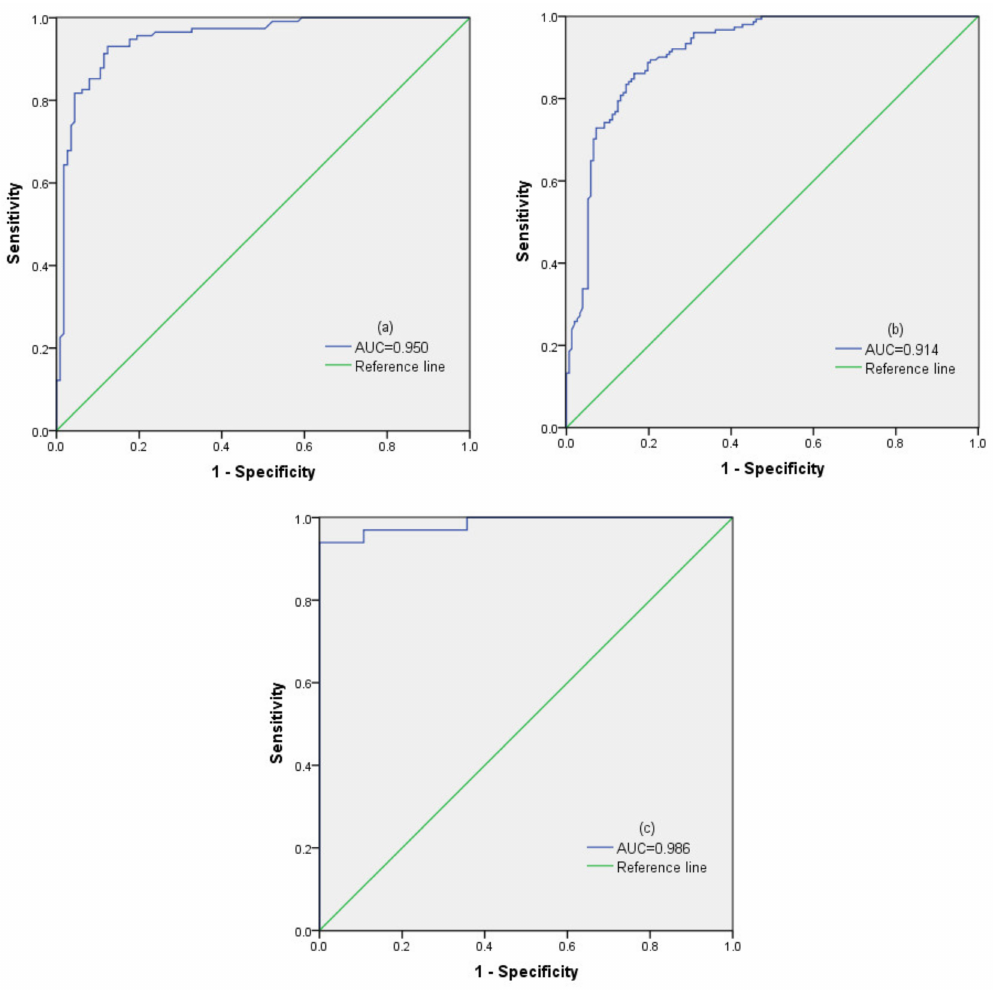
Figure 7. The ROC curves based on training data. ( a ) The ROC curve of collapse. ( b ) The ROC curve of the landslide. ( c )The ROC curve of debris